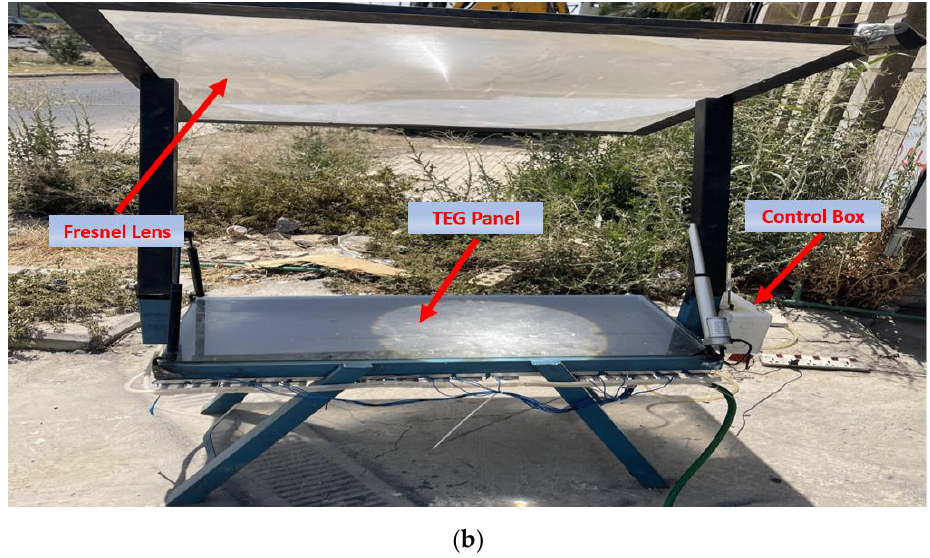
Figure 5. ( a ) A schematic of the TEG system, ( b ) TEG panel exposed to solar radiation via a Fresnel lens.